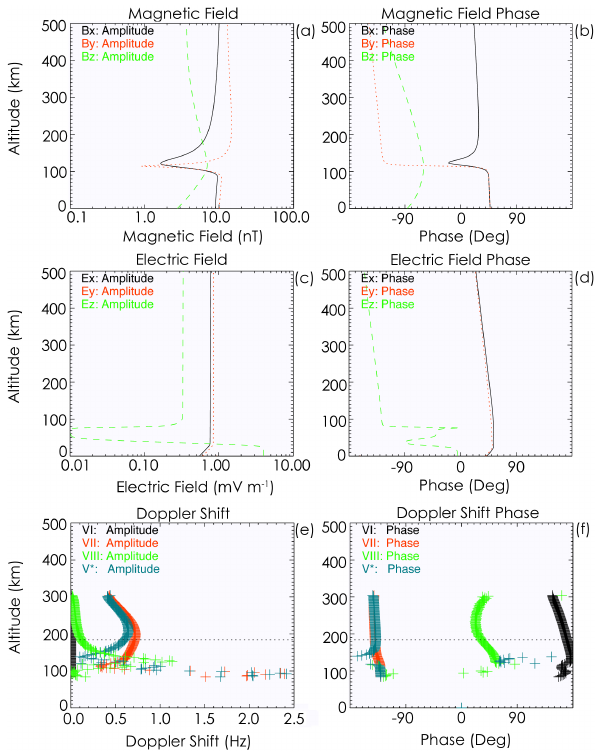
Fig. 7. Results of one run of the 1-D Numerical Model for a purely shear Alfvénic incident wave mode for an altitude range from the ground to 500km. Panel (a) presents the variation of the three magnetic field components with altitude. Panel (b) shows the magnetic field phase variation for the same three components. Panel (c) shows the Electric field variation for the three field com- ponents as a function of altitude. Panel (d) shows the electric field phase for the same three components. Panel (e) shows the Doppler shift mechanism contributions as a function of altitude. Black is the magnetic mechanism contribution ( V I ), red is the advection mechanism contribution ( V II ), green is the compression mech- anism contribution ( V III ) and blue is the overall Doppler shift given by the vector addition of the three Doppler shift components ( V ∗ = V I + V II + V III ). Panel (f) shows the phase variation for the same mechanisms as given in panel (e) and is colour coded in an identical fashion. The overplotted black dotted line highlights the DOPE reflection altitude, at roughly